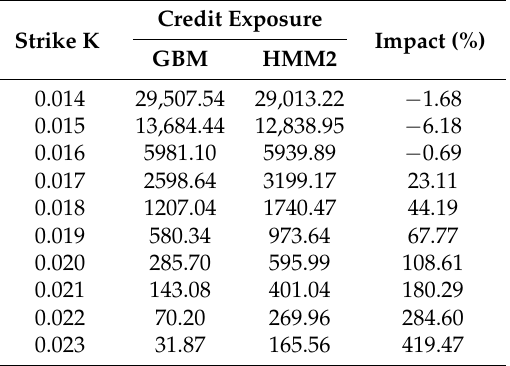
Table 5. Credit exposure values for out-of-the-money (OTM) options on the RUB/EUR exchange